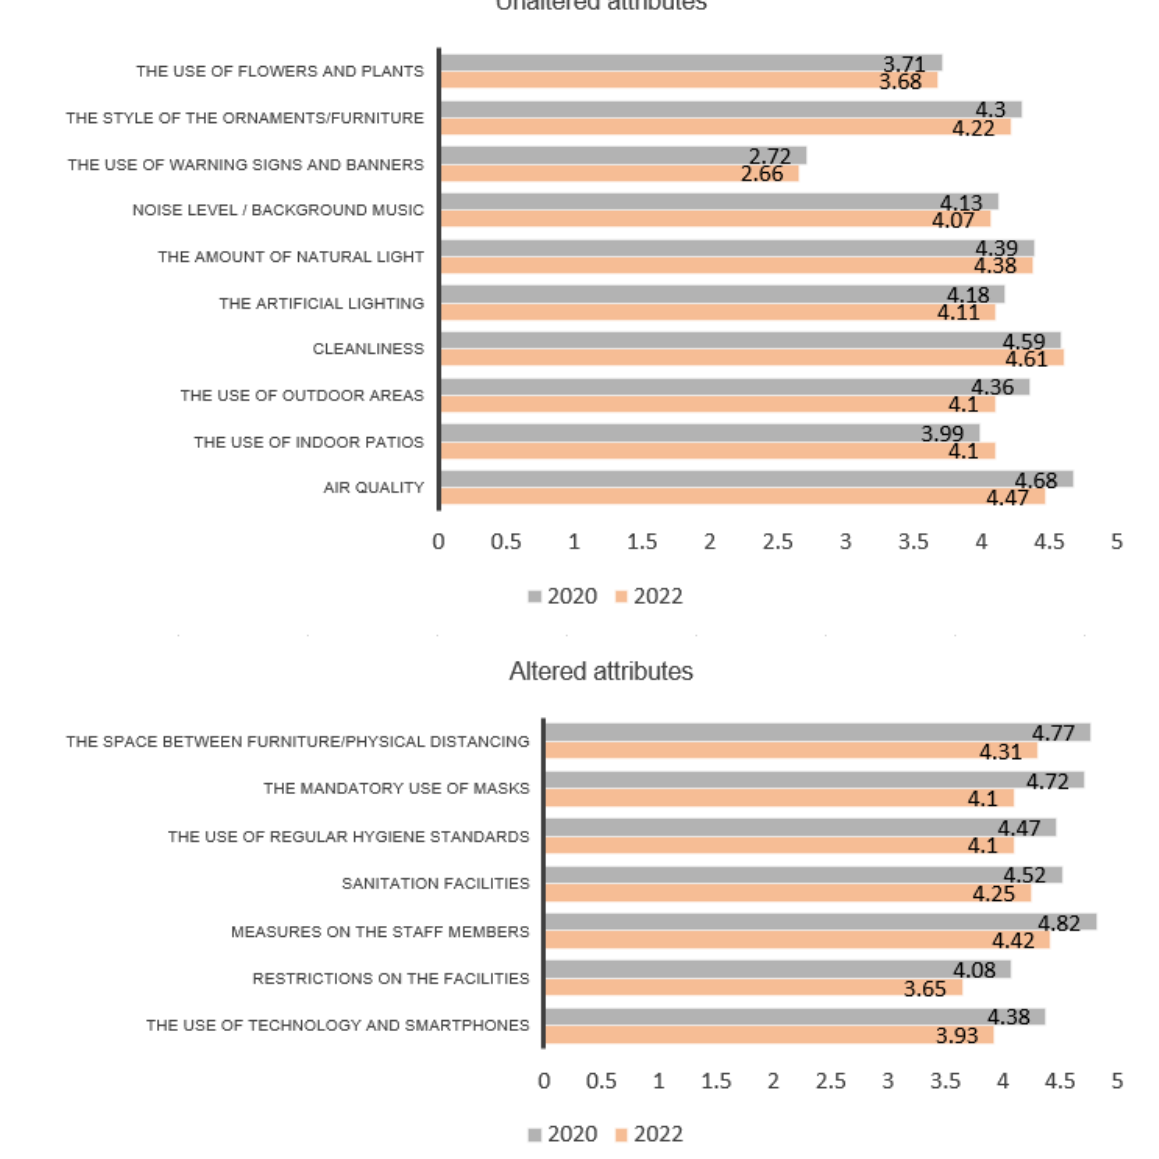
Figure 13. Unaltered and altered attributes for a sustainable recovery.